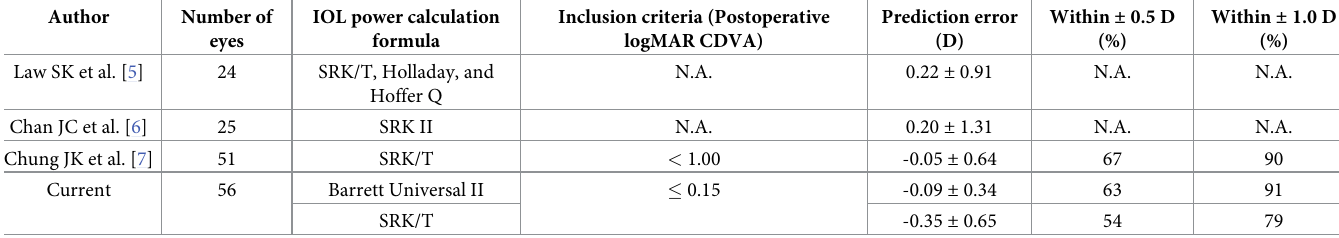
Table 2. Summary of previous studies on the predictability of intraocular lens power calculation in eyes undergoing combined cataract surgery and trabeculectomy.